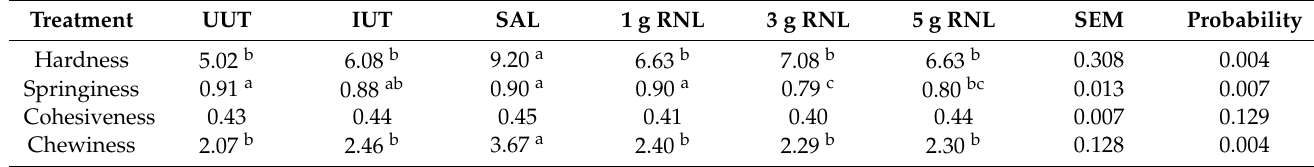
Table 6. Texture profile analysis in breast meat of broilers fed a diet supplemented with Rumex nervosus leaves.